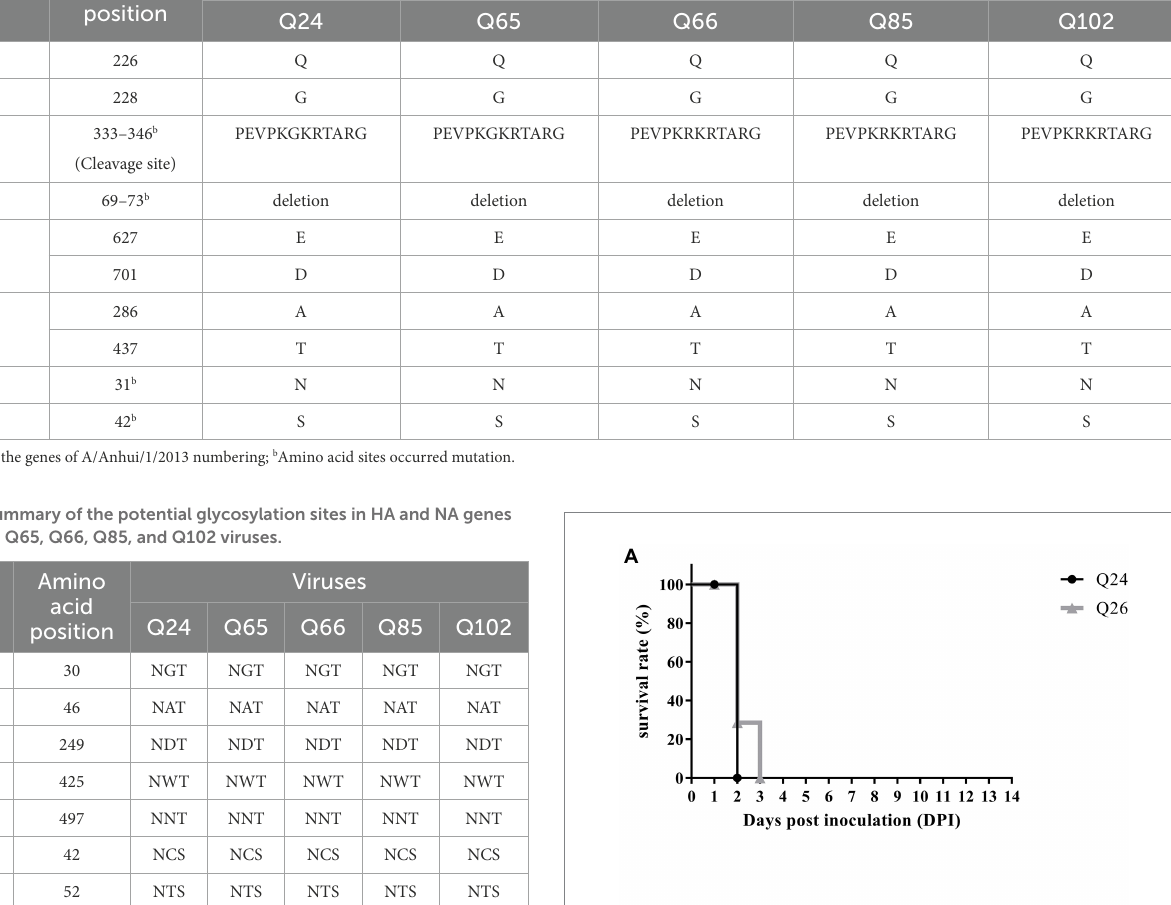
TABLE 2 Summary of signature amino acids in Q24, Q65, Q66, Q85, and Q102 viruses. Amino acid Genes a position